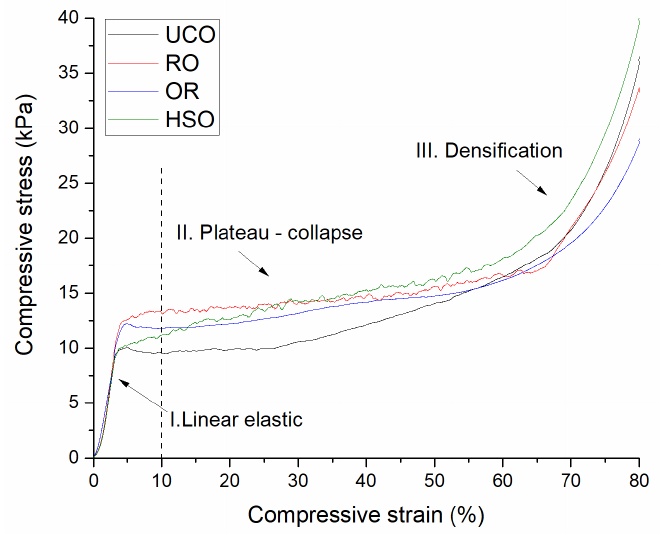
Figure 7. Stress–strain curves of the polyurethane foams showing the linear elastic, plateau-collapse and densification regimes.